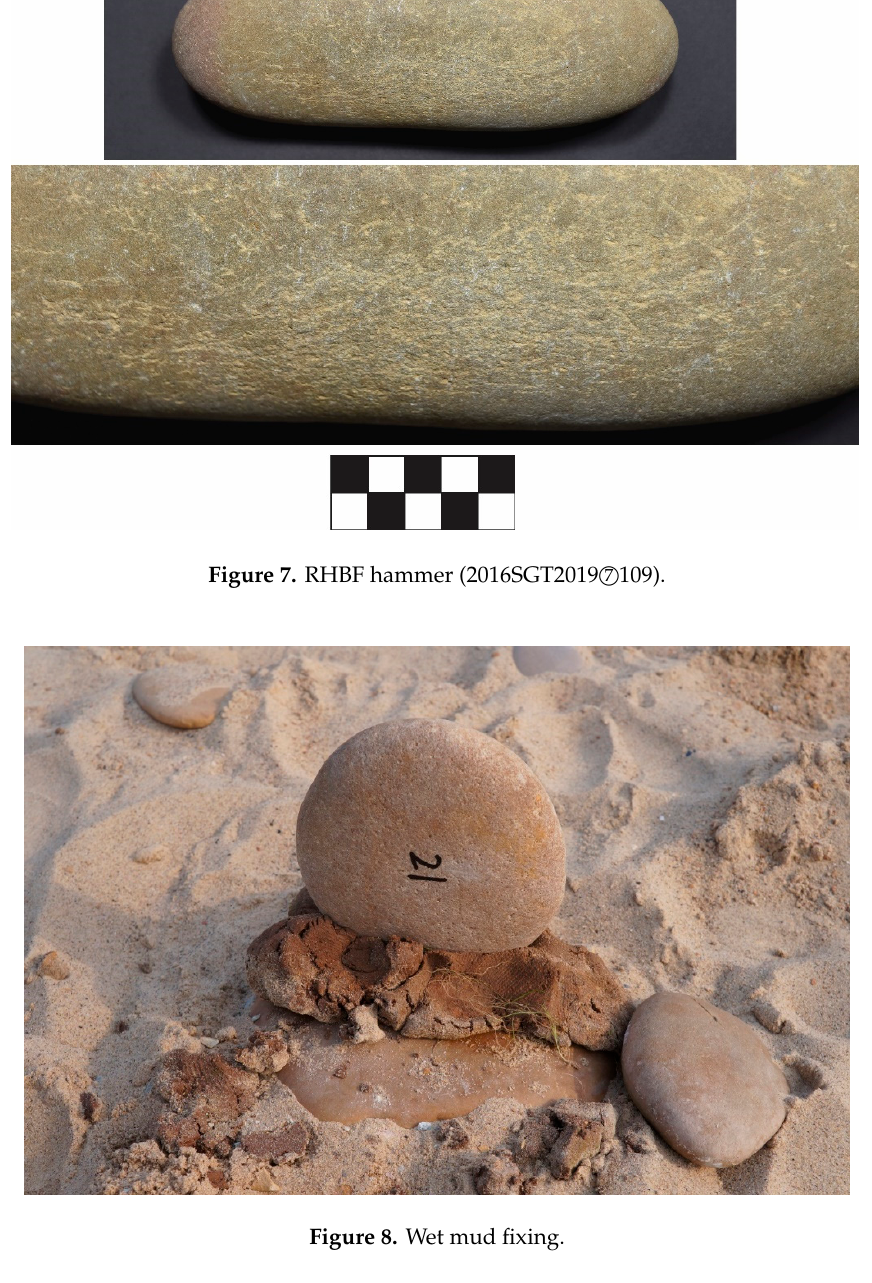
Figure 7. RHBF hammer (2016SGT2019 ⑦ 109).